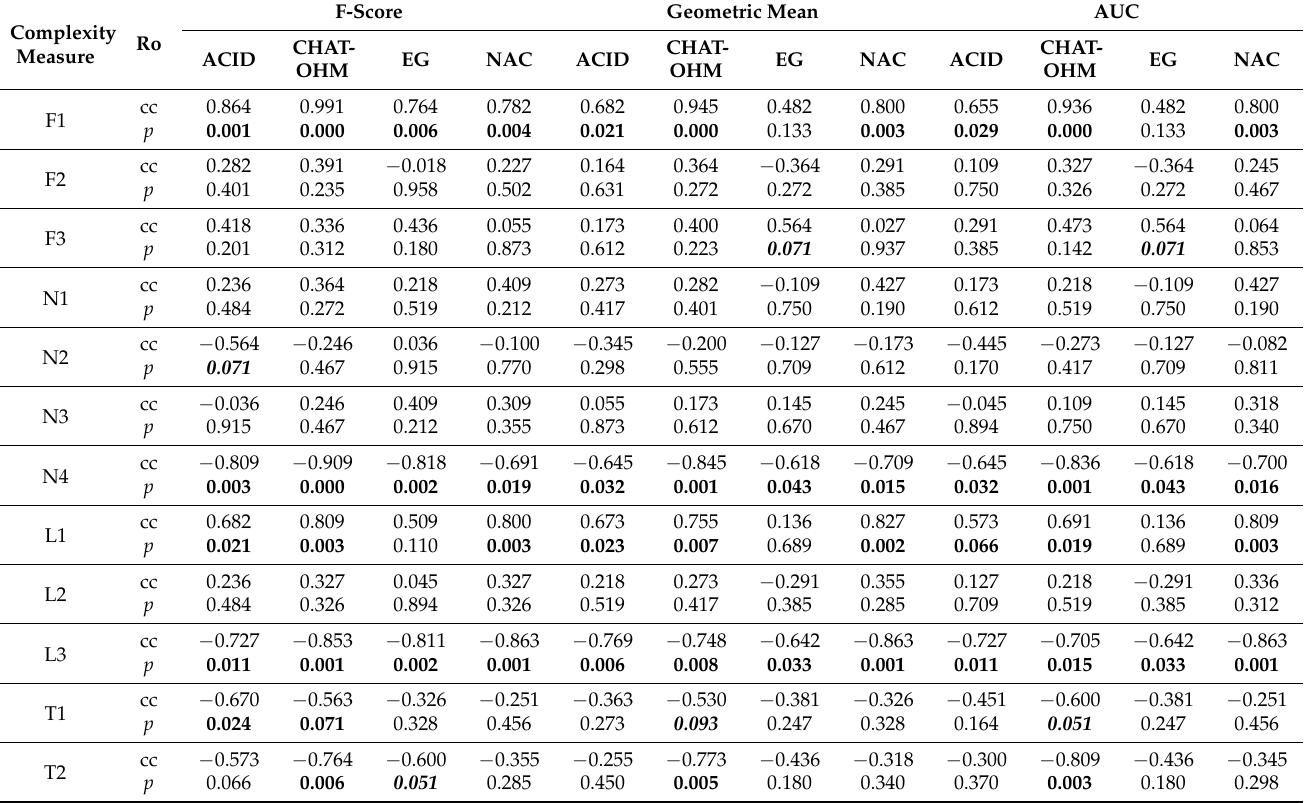
Table 8. Correlation analysis of the data complexity measures and the performance